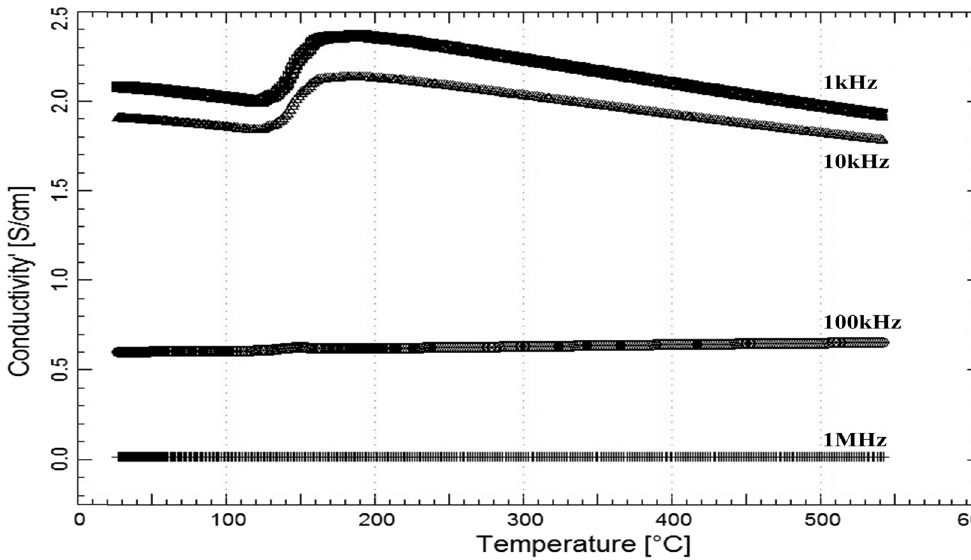
Figure 7: AEPA graphs of the composition - dependent change in conductivity - received 33% Ni - coated Fe – 33% Co composite.